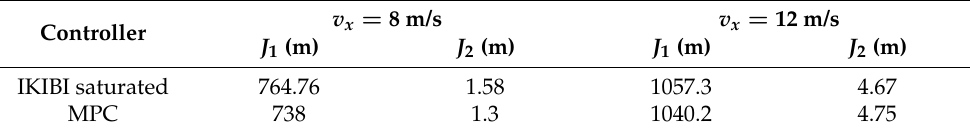
Table 4. Cost indexes: slow sensor feedback test with noise using the